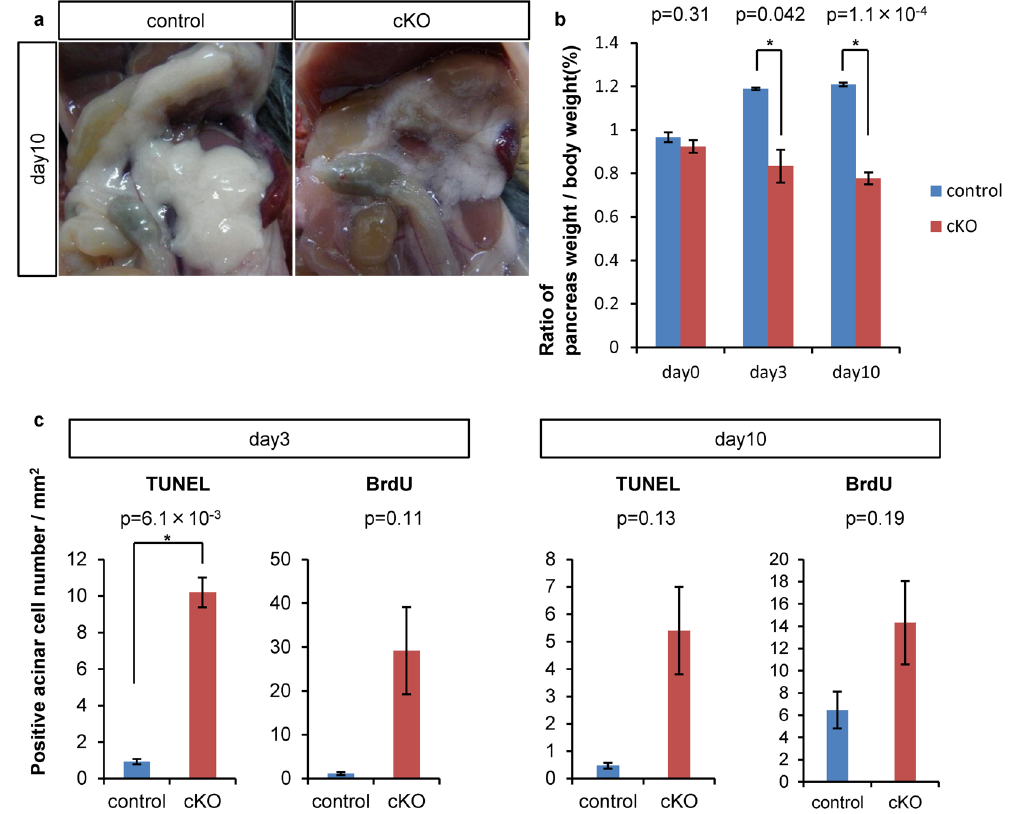
Figure 1. Acinar-specific Ptf1a deletion decreased pancreatic volume through activated apoptosis. ( a ) Representative pancreatic appearance of control and Ptf1a cKO mice on day 10. ( b ) Relative pancreatic weight per body weight. control, n = 3; Ptf1a cKO, n = 3. ( c ) The number of TUNEL or BrdU positive acinar cells per mm 2 on day 3 or 10. control, n = 3; Ptf1a cKO, n = 3. * P <